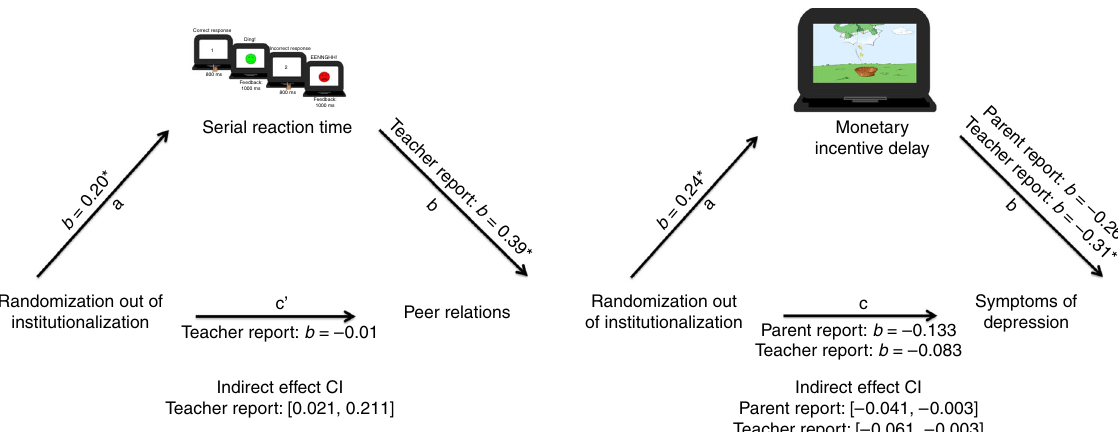
Fig. 4 Illustration of the primary mediation effects for both SRT and MID tasks. (SRT: N = 44 FCG; N = 37 CAUG; N = 42 NIG; MID: N = 48 FCG; N = 42 CAUG; N = 46 NIG). Con fi dence intervals are boot-strapped, bias-corrected con fi dence intervals around the indirect effect. Adapted with permission from ref. 34 . All rights reserved. A * indicates when the a and b paths were signi fi cant ( p